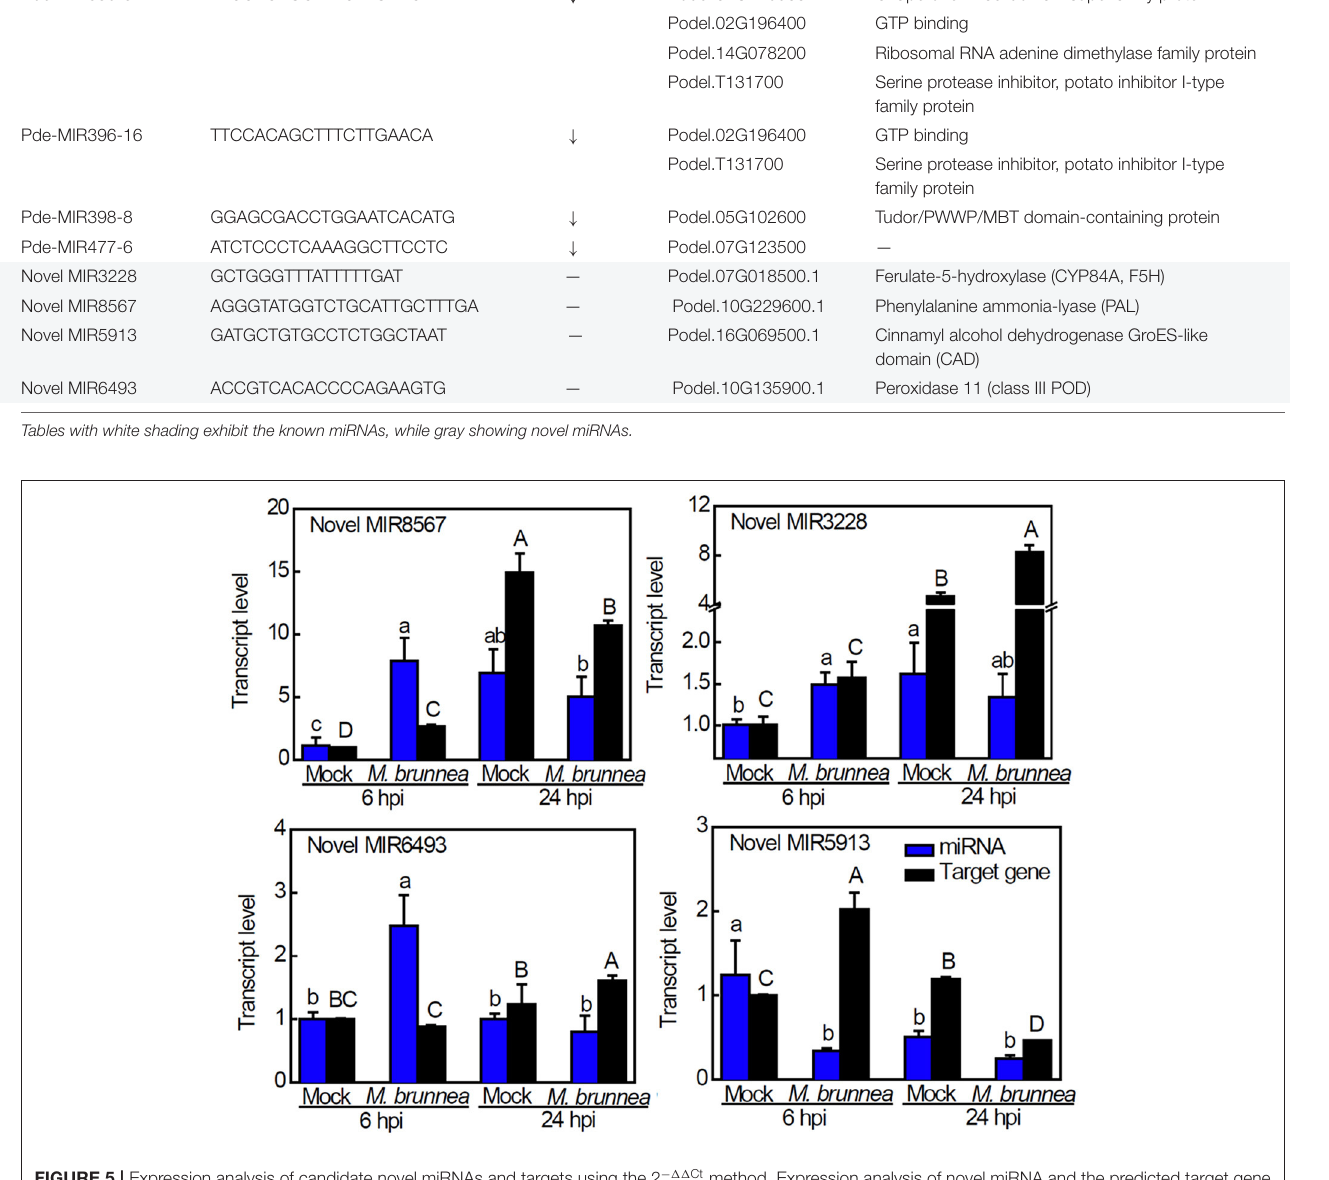
FIGURE 5 | Expression analysis of candidate novel miRNAs and targets using the 2 − 11 Ct method. Expression analysis of novel miRNA and the predicted target gene in the sample. The blue bar represents the qPCR validation result of novel miRNA and the black bar stands for the qPCR result for the target gene. The results of qPCR are presented as mean values ± SD; n = 3. The results of FPKM are presented as mean values; n = 3. Lowercase letters indicate significant differences in qPCR results between treatments, with capital letters for FPKM values or the qPCR-validated target gene expression ( P <